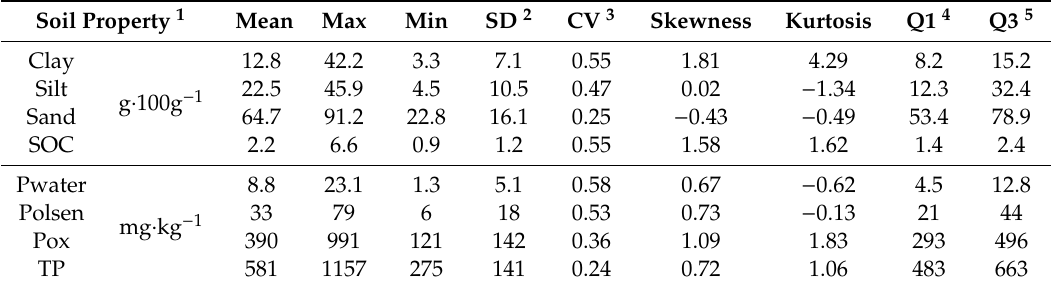
Table 1. Descriptive statistics of texture, organic carbon (SOC), water-extractable P, Olsen P, Oxalate-extractable P and total P for the 147 soil samples investigated in this